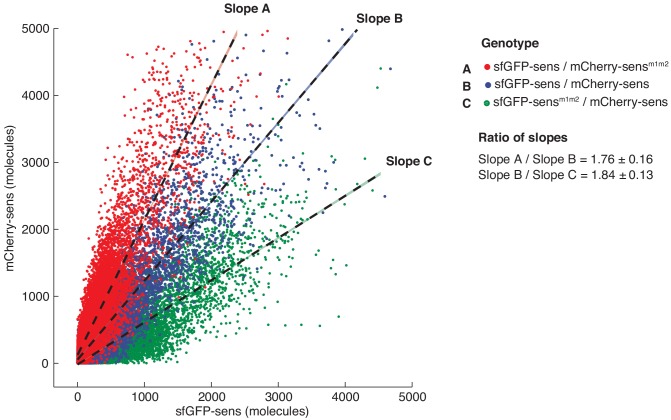
Fluorescent protein tags sfGFP and mCherry behave interchangeably in vivo.Single wing disc cells of the indicated genotypes were imaged and their nuclear sfGFP and mCherry fluorescence intensity was measured. Cells from individual discs were pooled separately to calculate the mCherry:sfGFP linear slope. Slopes were compared across genotypes (with relative errors propagated) to sensitively assay if the nature of the fluorescent protein tag interferes with quantitative protein measurements. No statistical difference was observed when fold-repression was calculated by mCherry-Sens ratios or by sfGFP-Sens ratios between wild type and mutant sens alleles.